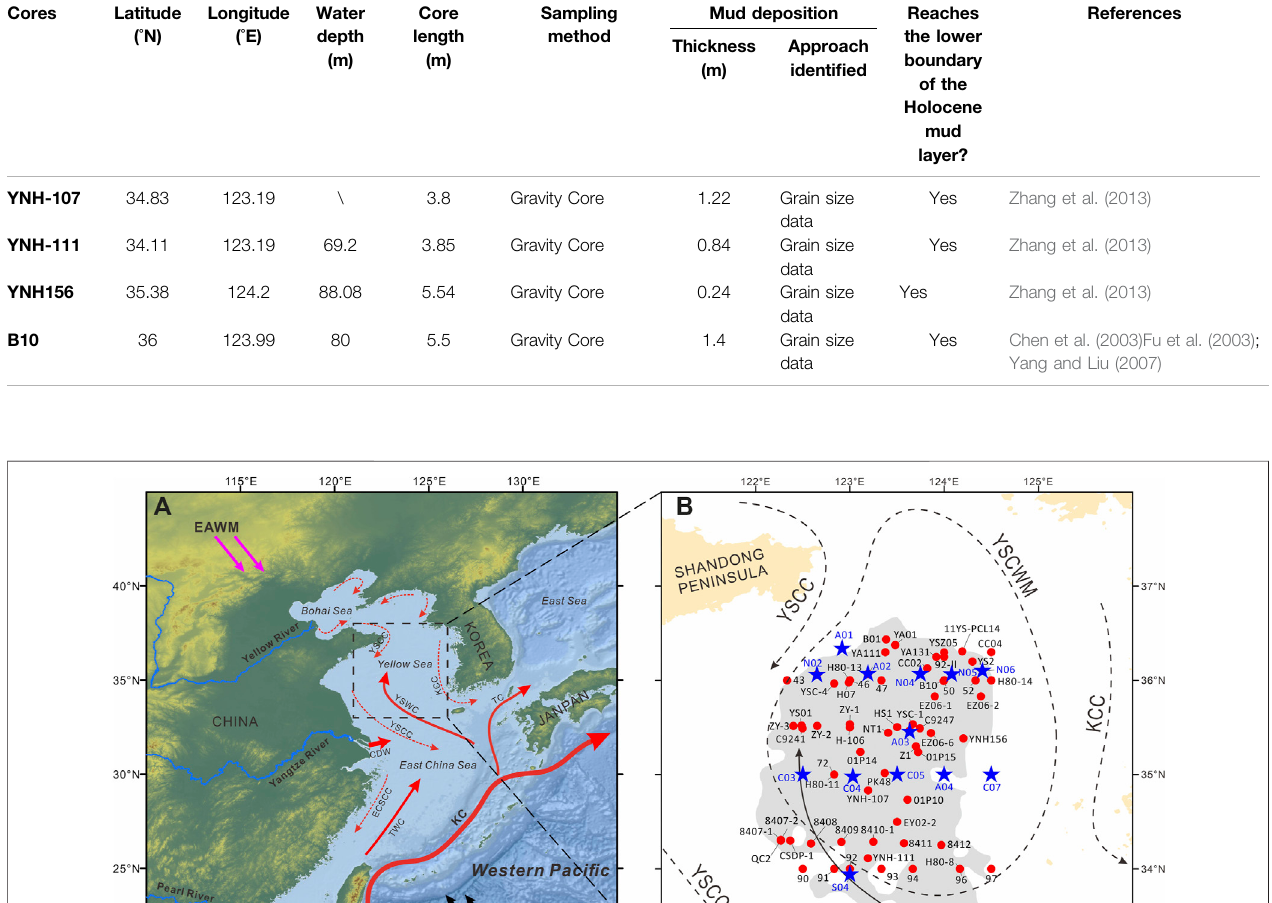
Frontiers in Earth Science |